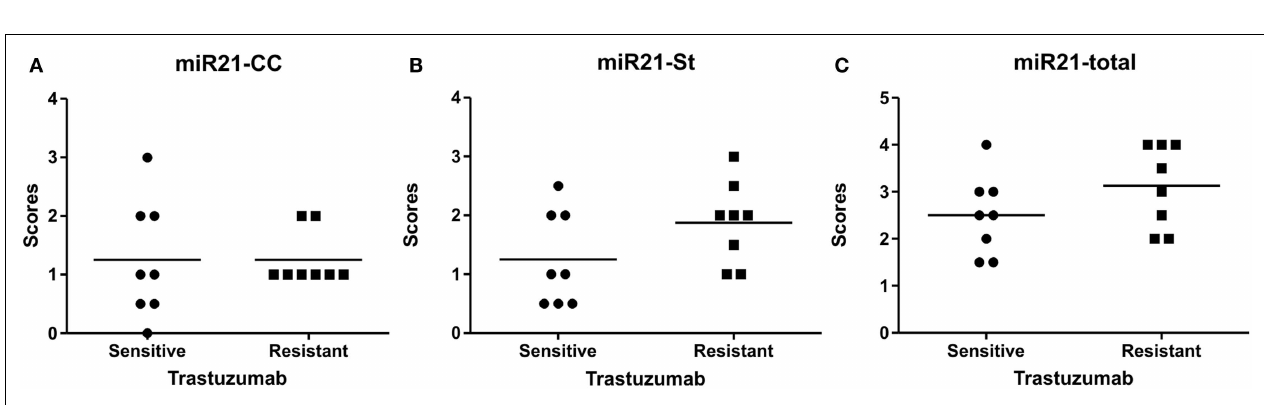
(C) .The scores are averages of two observers and here presented in scatter grams. Mann–Whitney U test: p = 0.69 for miR-21 CC , p = 0.13 for miR-21 St , and p = 0.20 for total